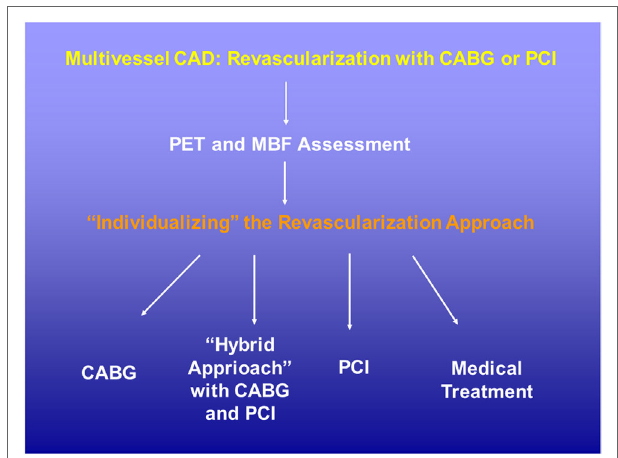
FiGURe 4 | Potential role of positron emission tomography (PET) perfusion and flow quantification in patients with multivessel CAD disease. The evaluation of the hemodynamic significance of each single CAD lesions with the assessment of corresponding hyperemic MBF and/or MFR may aid in the decision-making process for coronary revascularization strategy. CABG, coronary aortic bypass graft; MBF, myocardial blood flow; MFR, myocardial flow reserve; PCI, percutaneous coronary